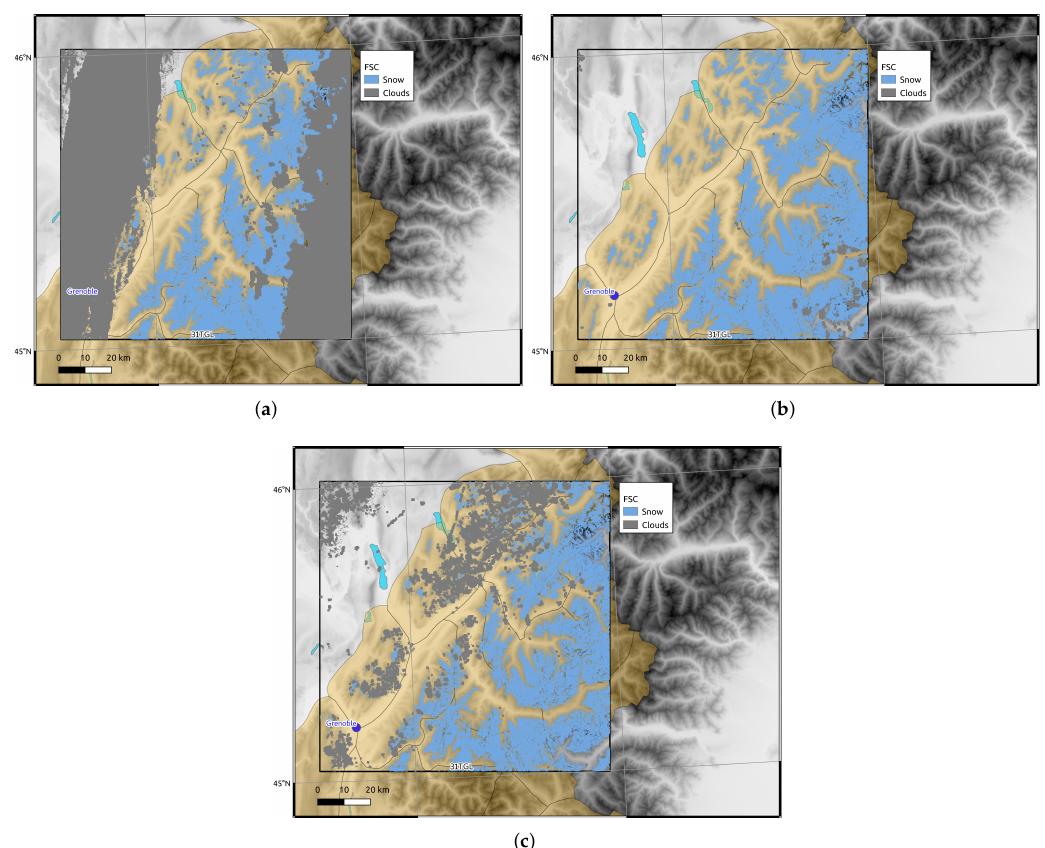
Figure 2. Maps of Snow cover maps derived from the Sentinel-2 Fractional Snow Cover products on tile 31TGL derived as of ( a ) 15 April 2018 ( b ) 20 April 2018 and ( c ) 25 April 2018.